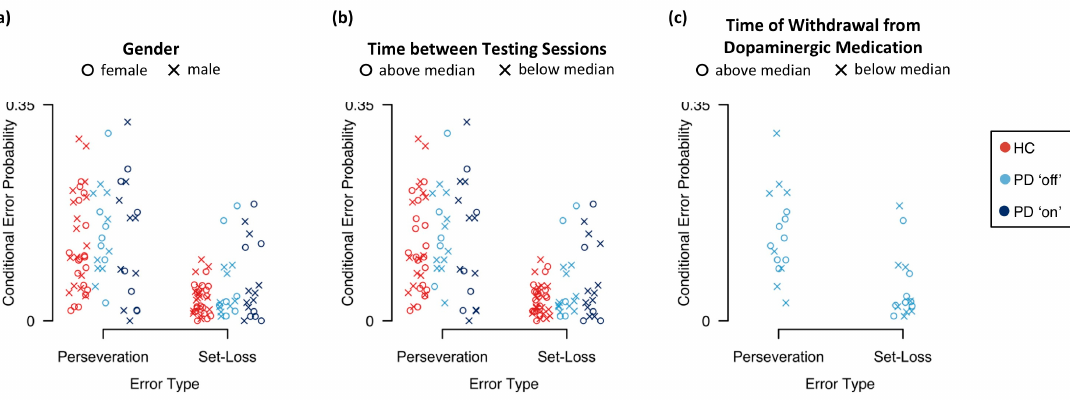
Figure A1. Individual conditional error probabilities separated by ( a ) gender, ( b ) median time between testing sessions, and ( c ) median time of withdrawal from dopaminergic medication.